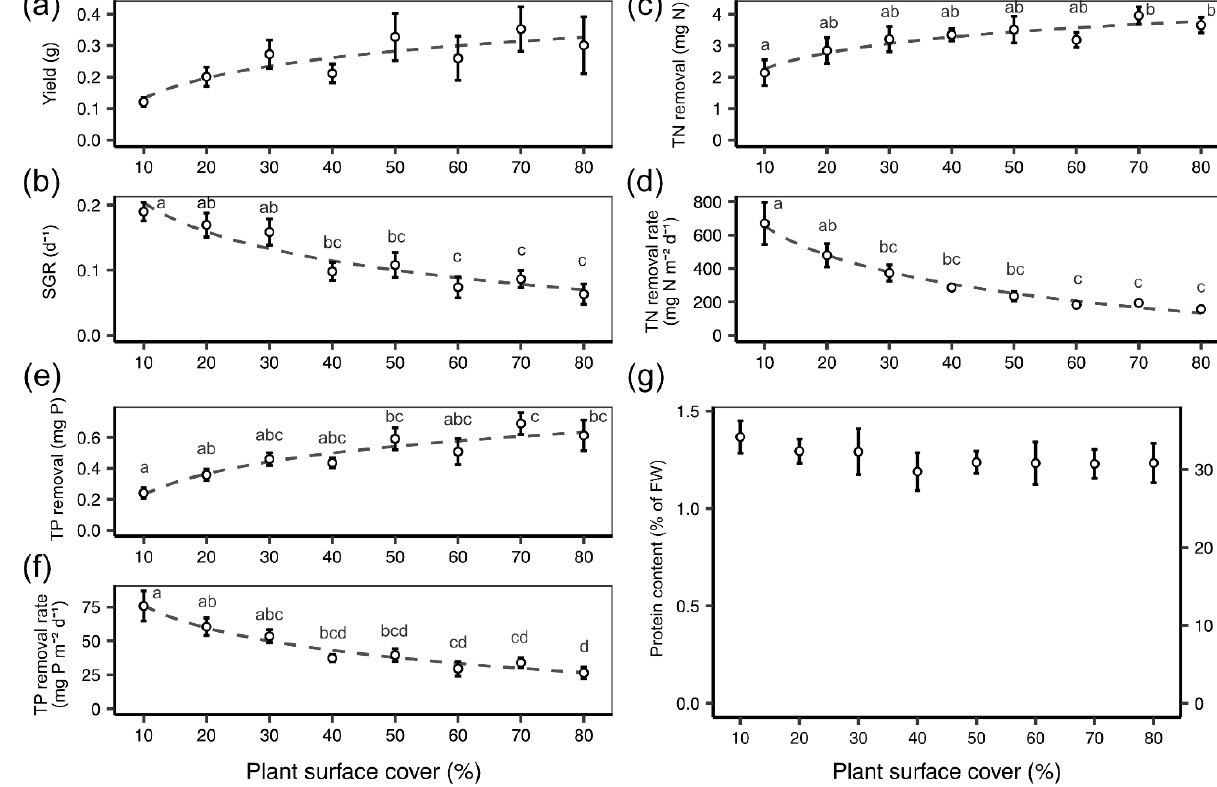
Figure 2. Mean ( ± SE) values with natural log trendline of ( a ) yield (g), ( b ) specific growth rate (SGR, d − 1 ), ( c ) total nitrogen (TN) removal (mg N), ( d ) TN removal rate per frond surface area (mg N m − 2 d − 1 ), ( e ) total phosphorous (TP) removal (mg P), ( f ) TP removal rate per frond surface area (mg P m −2 d −1 ) and ( g ) % protein content based on fresh duckweed biomass, FW, and dry duckweed biomass, DW, for L. minor grown on synthetic wastewater over 7 days under a range of plant surface covers (10 – 80%). Points that do not share the same letter significantly differ from one another, as per the Tukey post hoc test, p < 0.05.